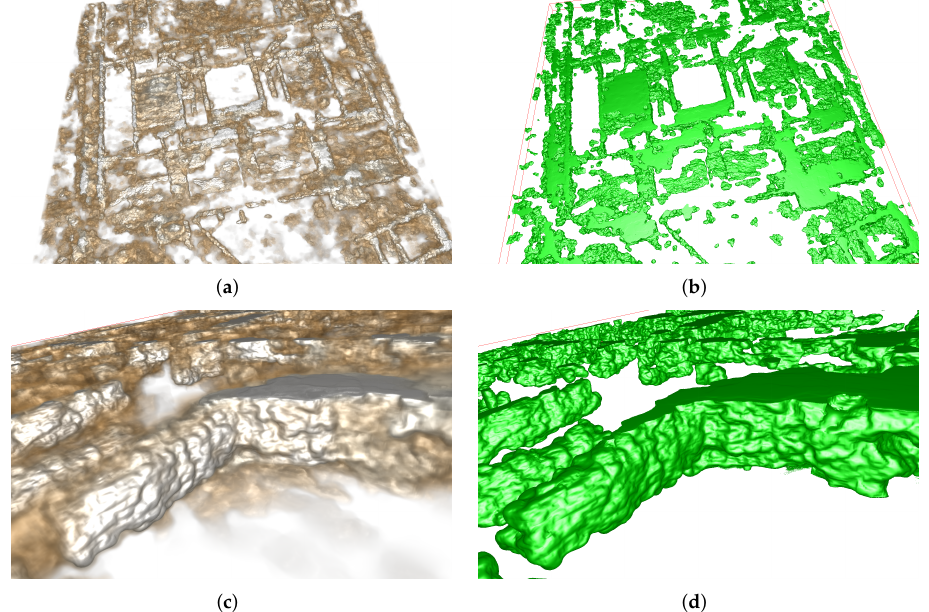
Figure 10. TV-L1-based volume visualization using a more aggressive filter setting of λ = 0.5, leading to the removal of most structures smaller than the wall diameter in the DVR result, while wall surface structure details are still visible ( a , c ). In the corresponding iso-surface visualization ( b , d ) these surfaces are even more defined at the expense of inner structural